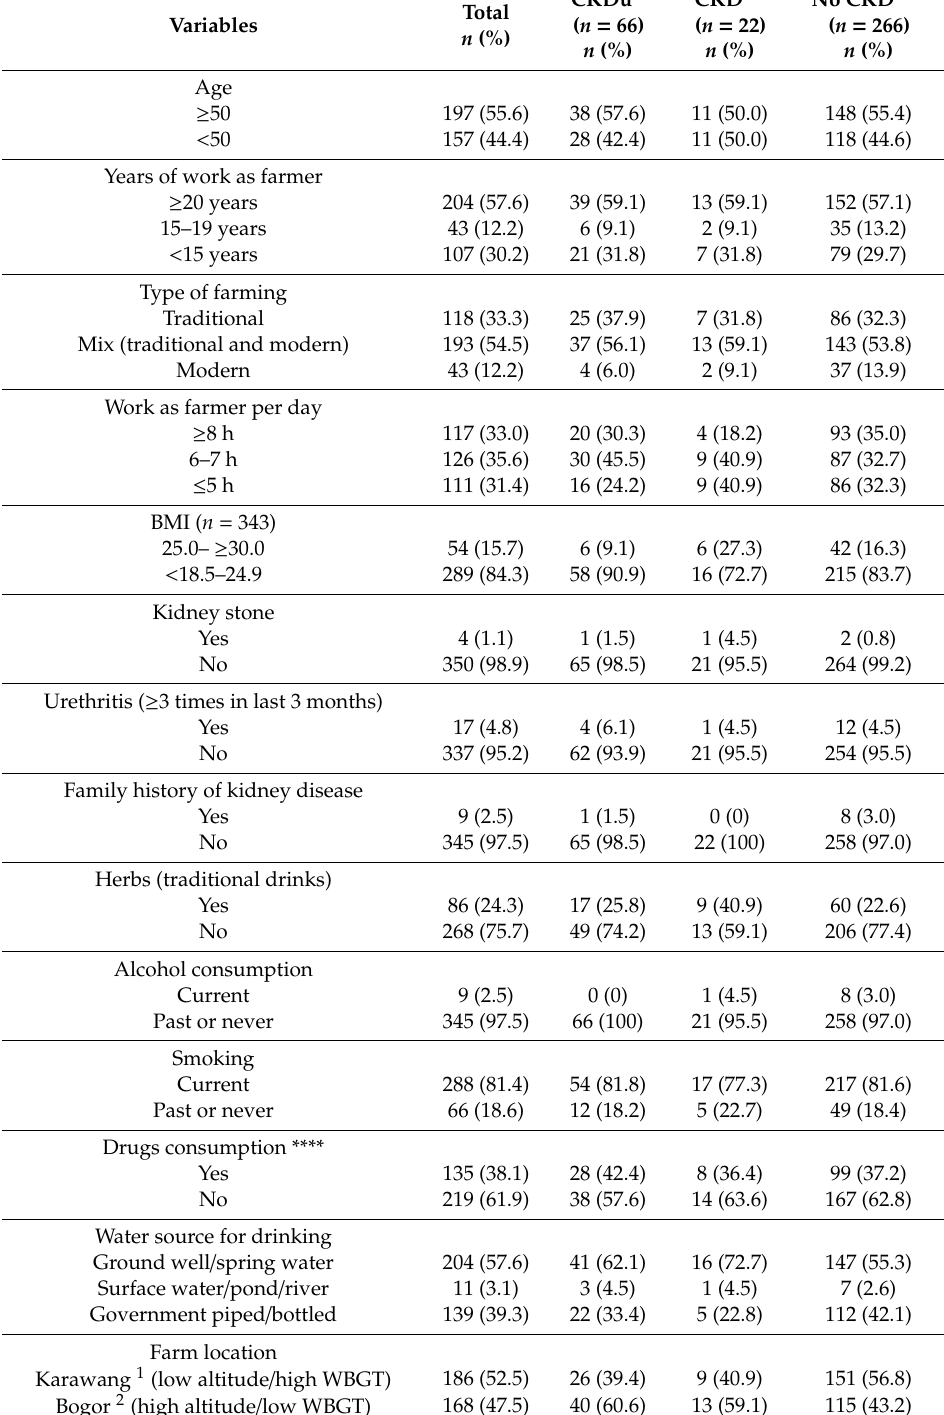
1 Karawang: location with low altitude and high WBGT. 2 Bogor: locationwith high altitude and low WBGT. * CKDu included subjects with CKD stages 1–4, but excluded subjects with diabetes based on blood sugar concentration ( > 200 mg / dL considered as diabetes) or self-reported diabetes or hypertension based on blood pressure (systole / diastole ≥ 140 / ≥ 90 considered as hypertension) or self-reported hypertension with medication or self-reporting of urethritis, gout and kidney stone. ** CKD included subjects with CKD stages 1–4 without the exclusion of subjects with diabetes, hypertension, urethritis, gout, kidney stone. *** No CKD included subjects with Normal status of CKD stages. **** NSAID drug consumption in the last 3